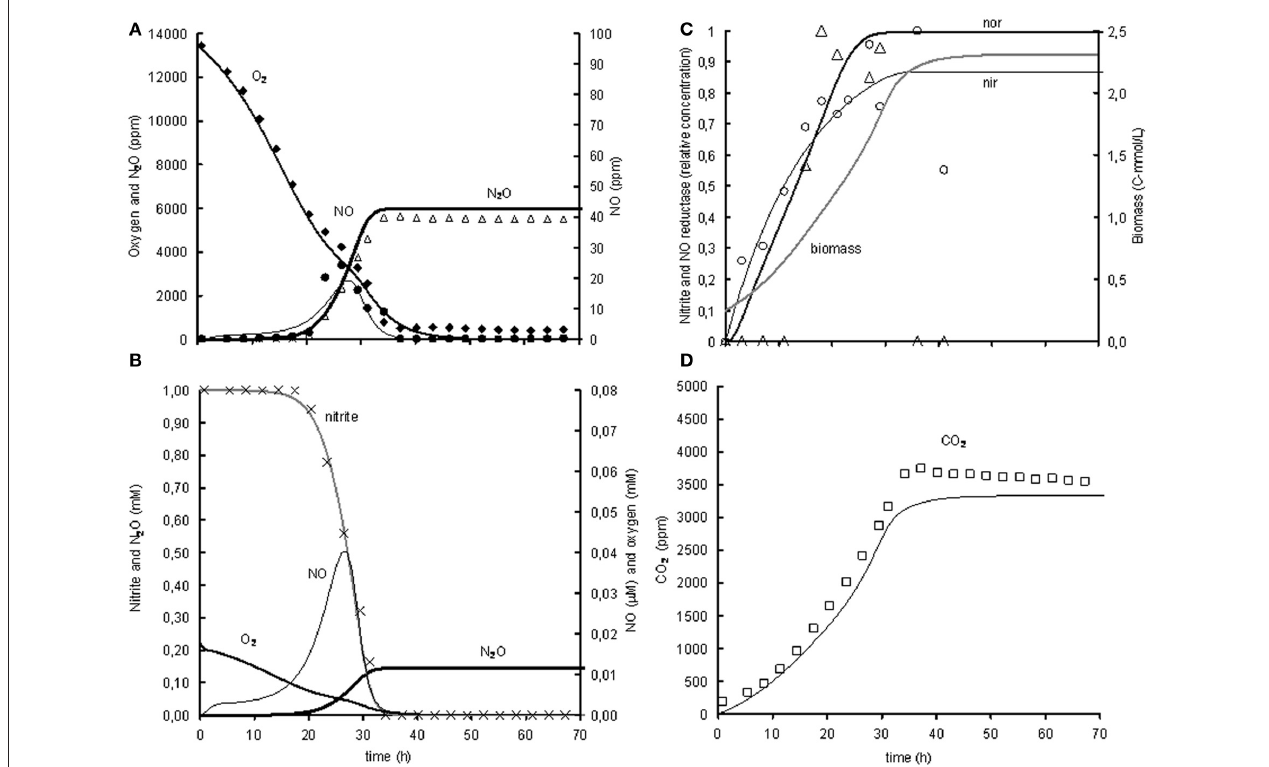
measured norB mRNA ( ρ ), and biomass